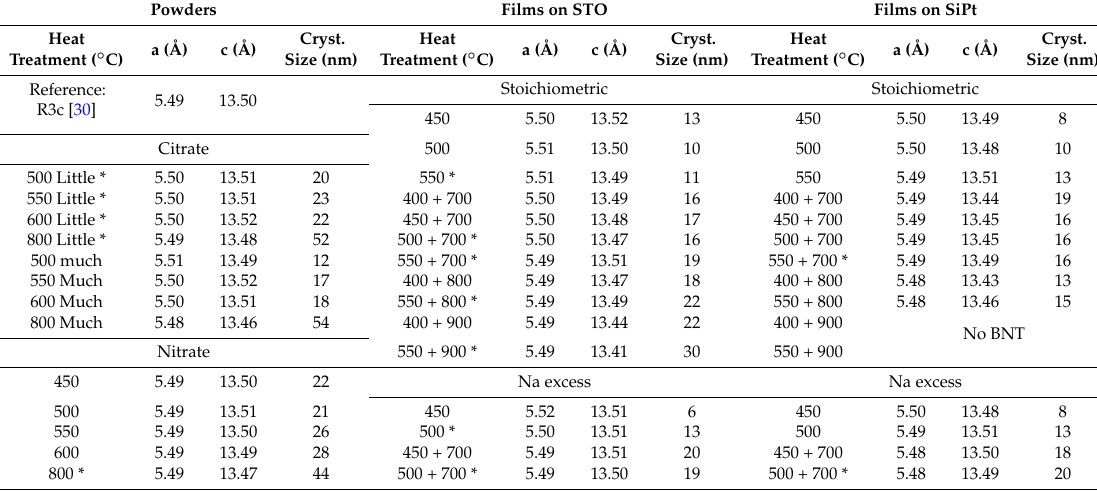
Table A1. Refined structural parameters for BNT phase in relevant samples. An asterisk (*) marks samples that are phase pure. Refinement of XRD patterns from films on SiPt required simultaneous refinement of Pt to allow BNT peaks to properly relax. Note that refinement of patterns from film samples results in too small crystallite sizes due to the inherent broad peaks obtained using grazing incidence XRD set